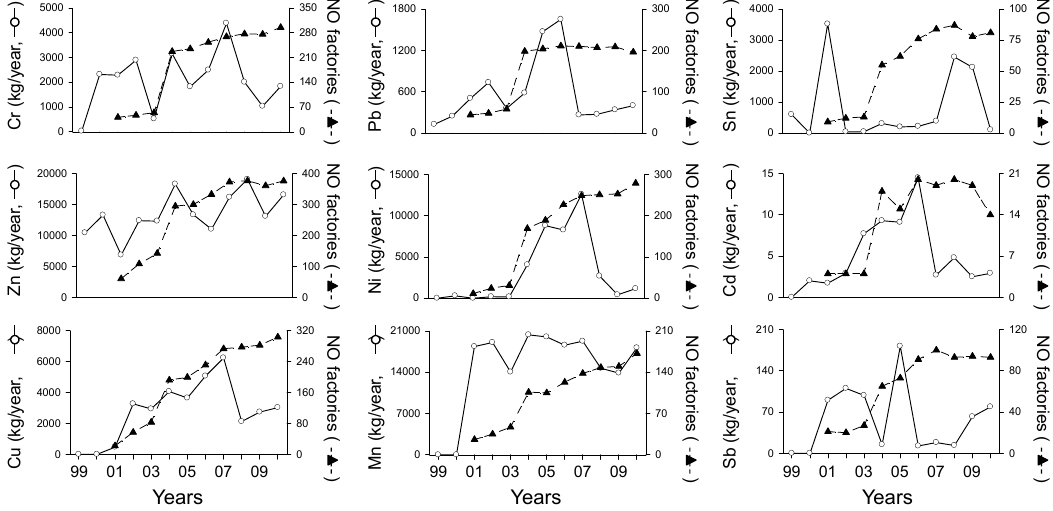
Figure 2. Changes of the number of industrial factories and effluents of nine heavy metals from 1999 to 2010.